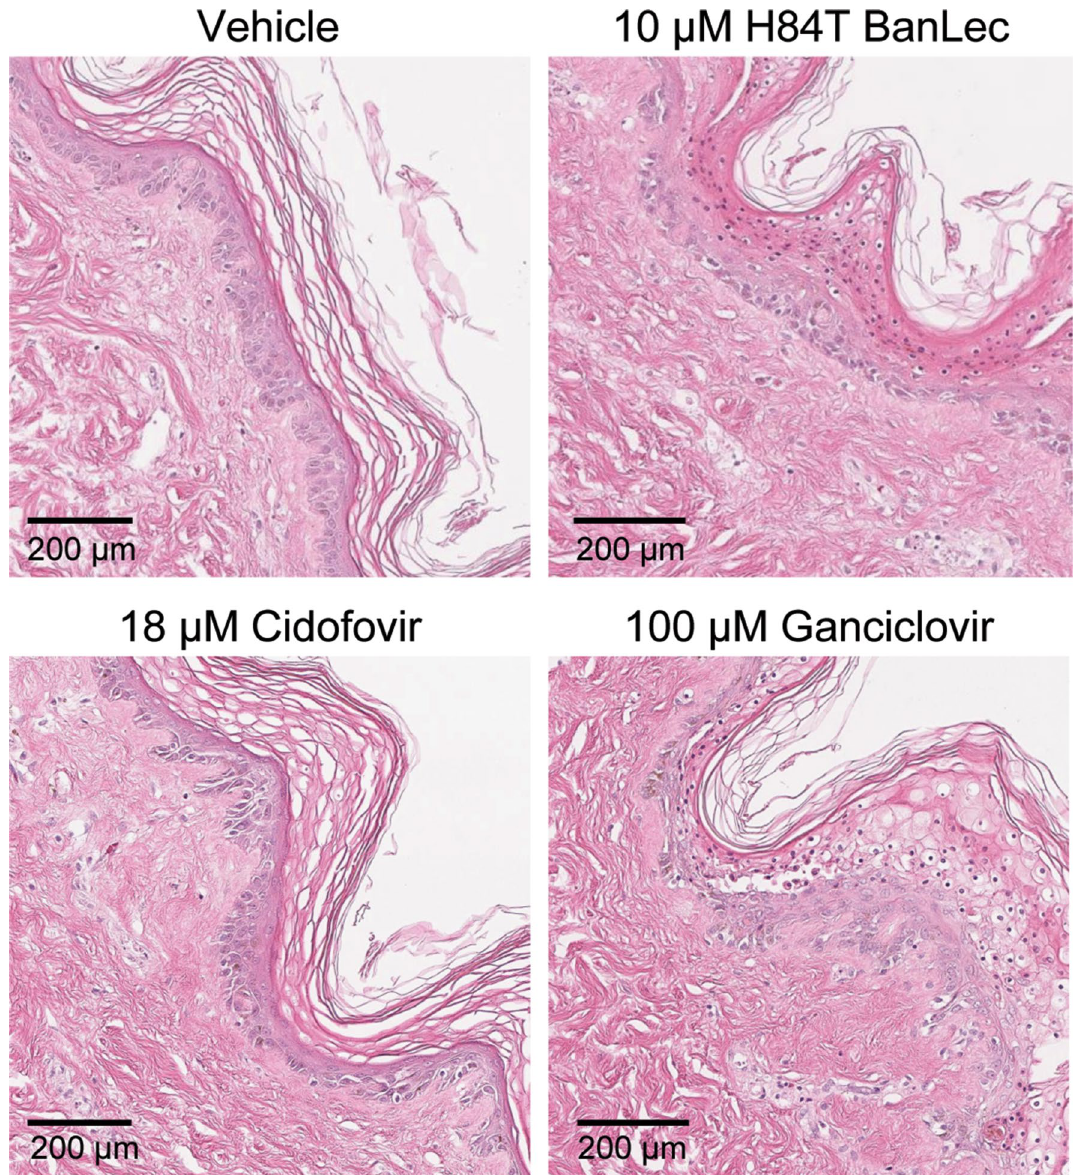
Figure 6. Effects of H84T BanLec on adult skin. Skin was infected with HCMV, cultured on Netwells, and treated every other day with compounds in the medium. Skin was collected 14 DPI and fixed in 4% paraformaldehyde for H&E staining. The epidermis faces the right side of the image (appears purple) and the dermis is to the left (appears pink). The epidermis appears normal, and the dermal–epidermal junction is intact (HCMV replicates in dermal cells). Images are representative of 2–3 sections per tissue sample from a single tissue